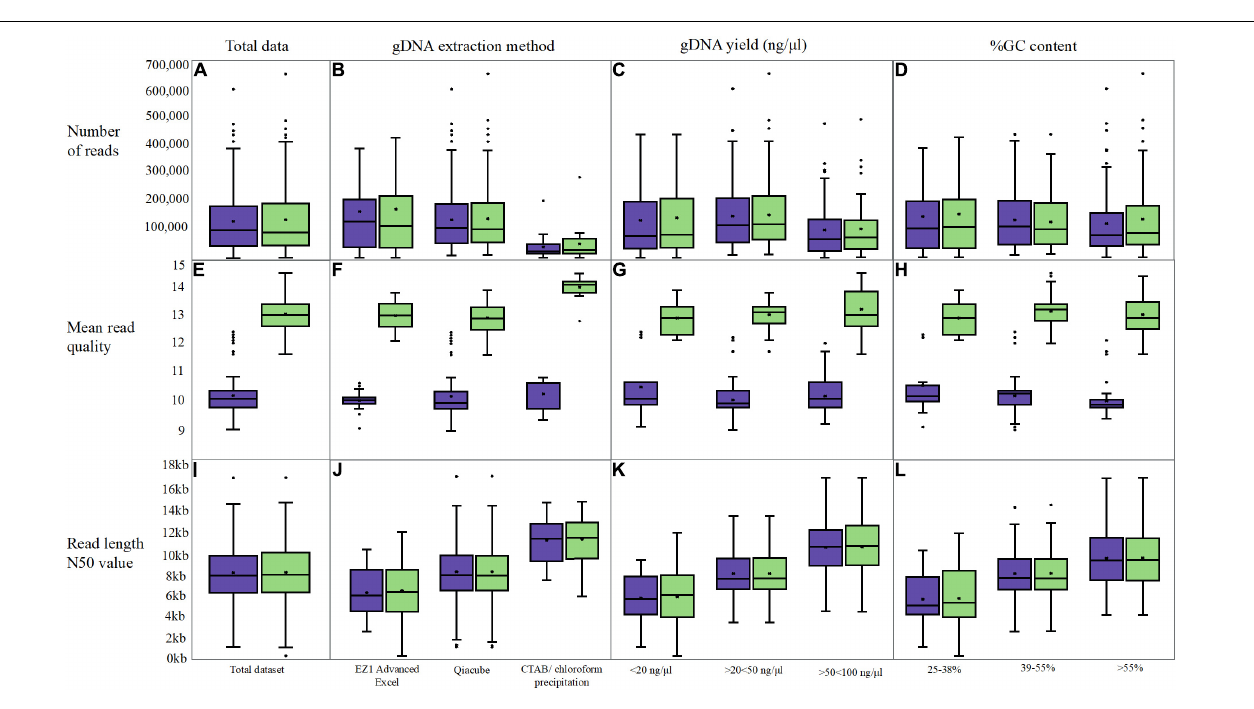
file with three contigs (1 length = 5,098,586 depth = 1.00x circular = true, 2 length = 110,795 depth = 0.43x circular = true, 3 length = 8,496 depth = 0.50x circular = true), whereas the re- analysis produced two complete contigs (1 length = 5,098,352 depth = 1.00x circular = true, 2 length = 110,797 depth =